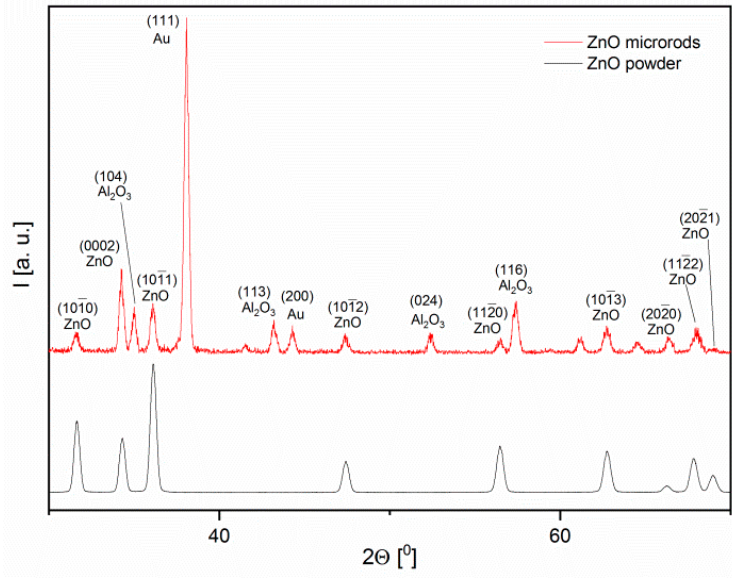
Figure 3. X-ray diffraction patterns of obtained ZnO layers (JCPDS 5-0664). Figure 3. X-ray di ff raction patterns of obtained ZnO layers (JCPDS 5-0664).